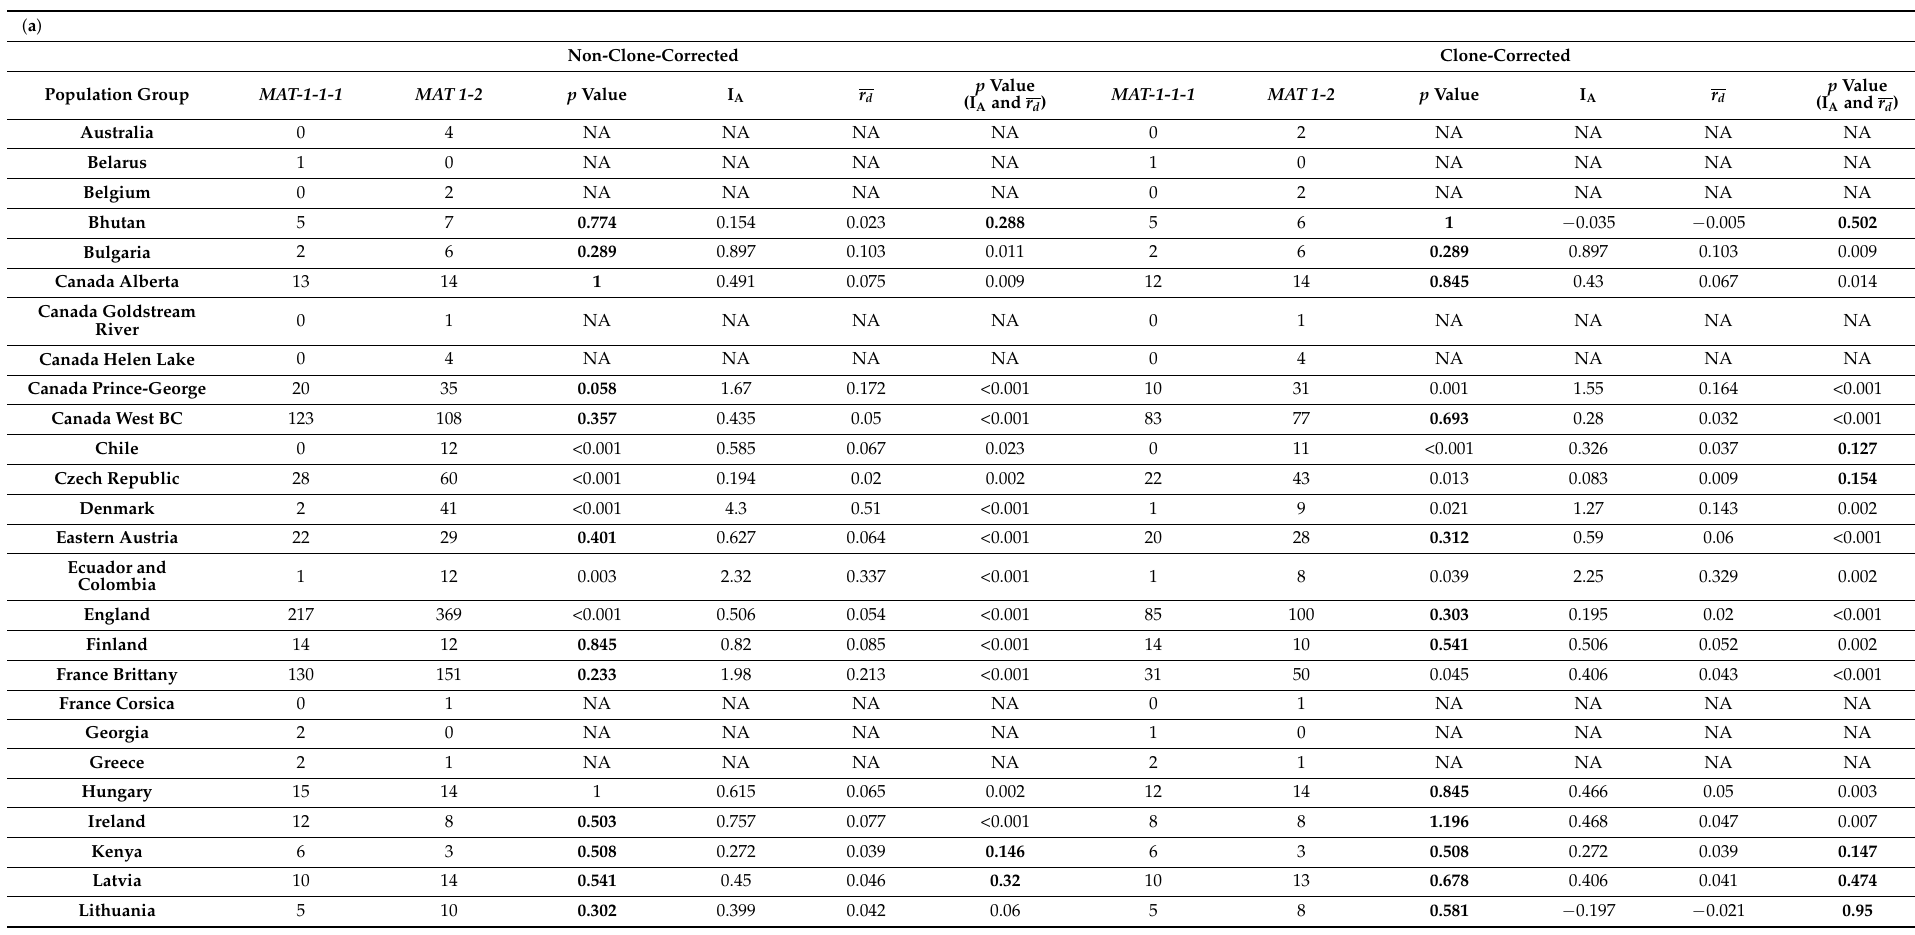
Table 2. Mating type ratio and index of association tests for the D. septosporum isolates of (a) the population groups; (b) the three main STRUCTURE clusters; (c) the three Eastern European subclusters. Bold p values (i.e., those that are non-significant) indicate random mating is supported by the